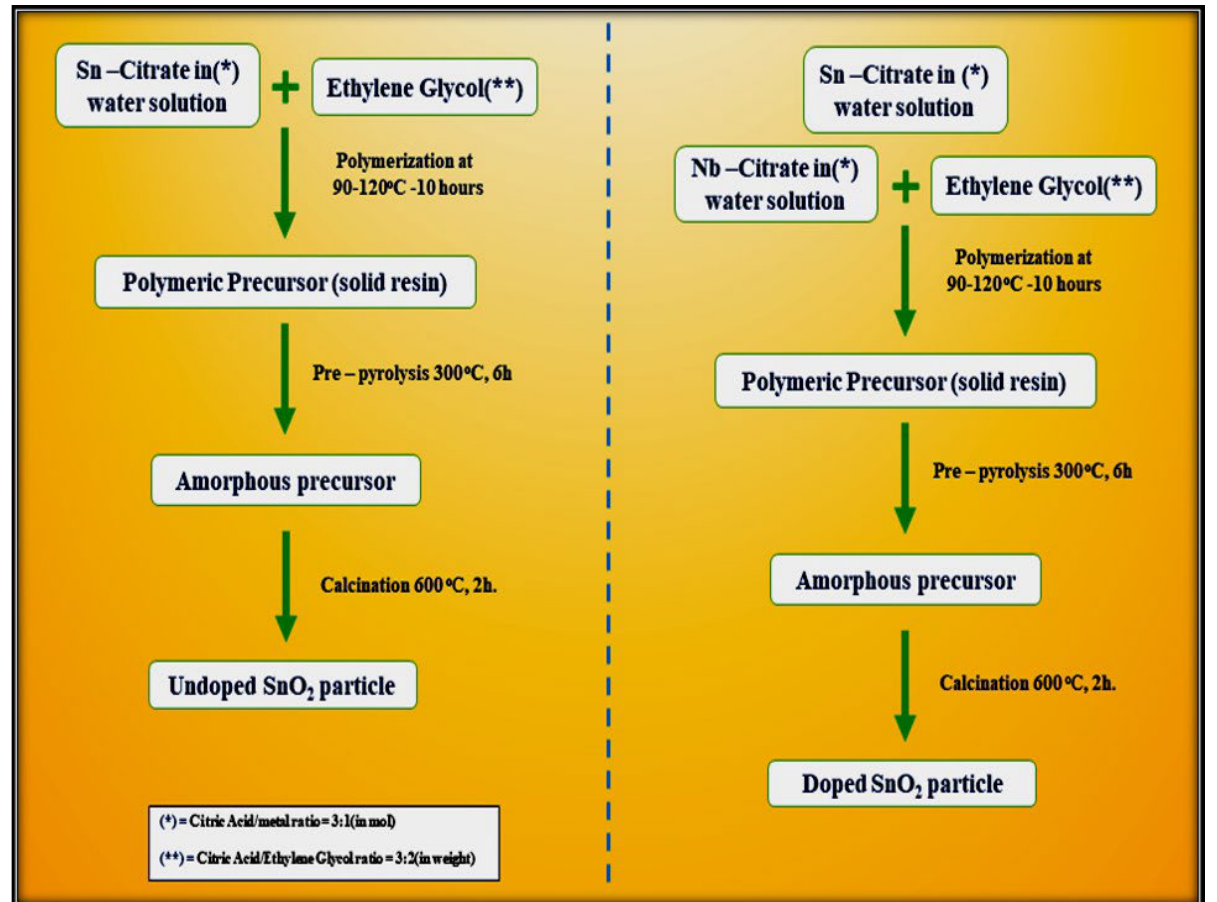
Figure 14. Mechanistic steps involved in the synthesis of undoped SnO 2 and Nb 2 O 5 –doped SnO 2 by polymeric precursor method.